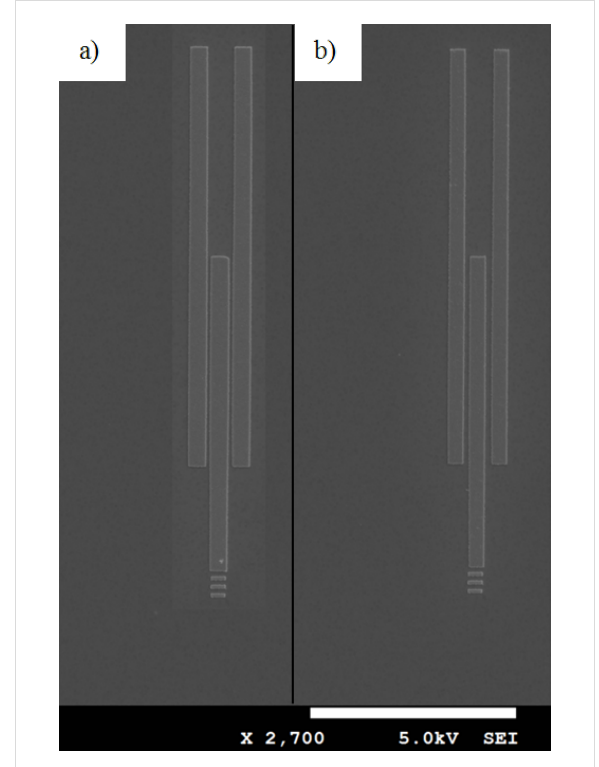
Figure 3: SEM images of interferometers with gap separation a) 200 nm and b) 300 nm. The scale bar in the figure represents 10